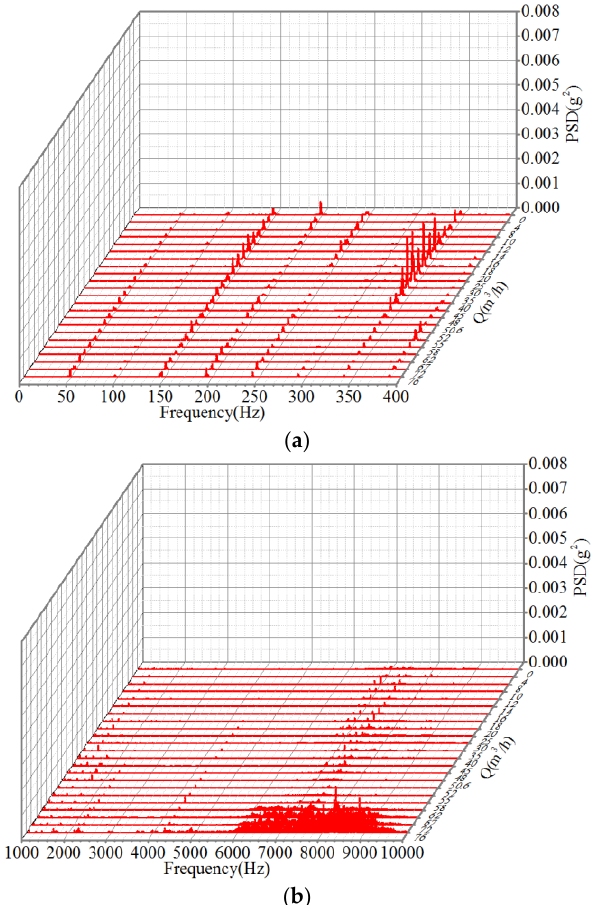
Figure 10. PSD of the vibration measured by accelerometer 4 under different flow rates. ( a ) 0 – 400 Hz, ( b ) 1 – 10 kHz.